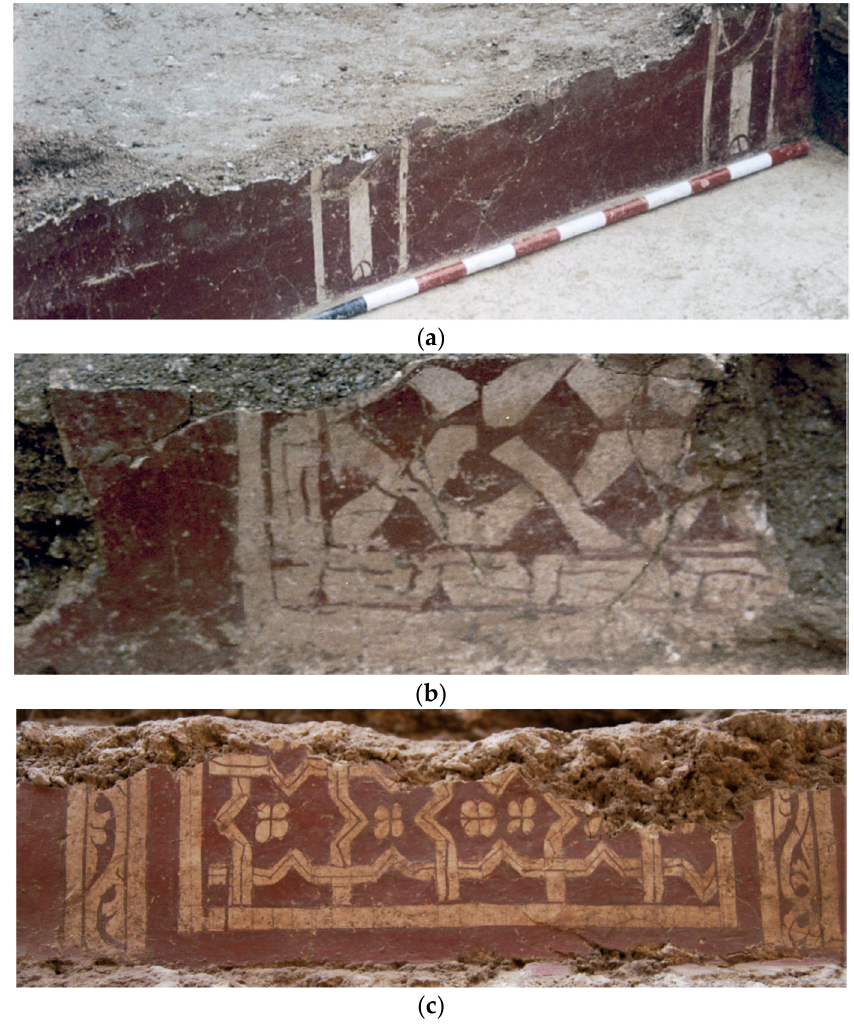
Figure 6. Pictorial coatings from the 11 th century in Almería: ( a , b ) Marín Street; ( c ) Mercado Central (García Granados 2014b, pp. 10, 11, 15).